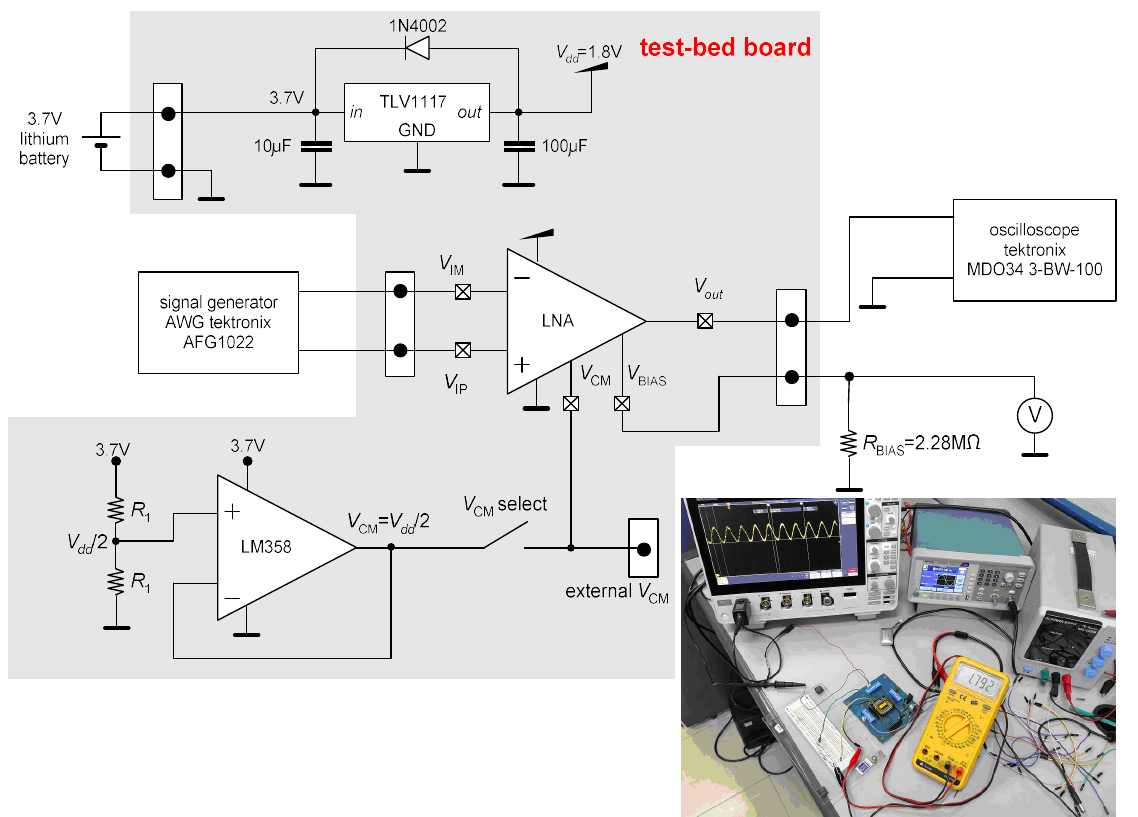
Figure 10. Schematic of the experimental setup for the characterization of the microdevice. The inset shows the setup photograph.